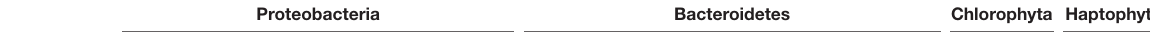
TABLE 2 | Compilation of functional features detected in one or more of the seven draft genomes recovered from the Amundsen polynya with a length > 2.5 Mb ( Oceanospirillaceae ASP10-02a; SAR92 ASP10-03a; Rhodobacteraceae ASP10-04a; Cryomorphaceae ASP10-05a; Polaribacter